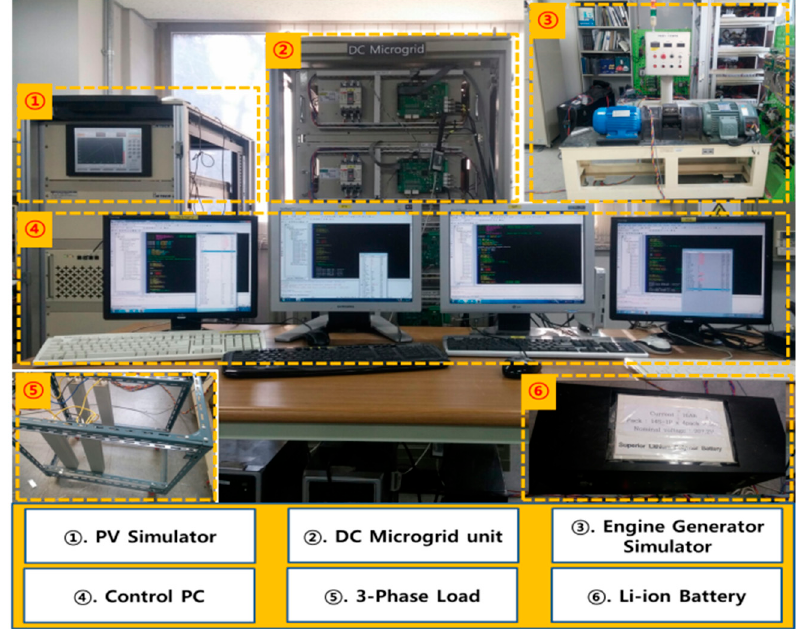
Figure 12. Scaled hardware test set.